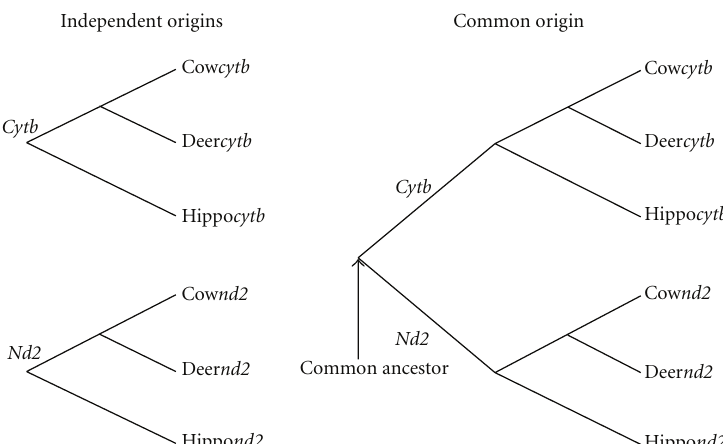
Figure 1: Independent origins hypothesis versus common origin hypotheses of cytb and nd2 . No branch exists connecting the two genes in the independent origins hypothesis, while the common ancestor of the two genes exists in the common origin